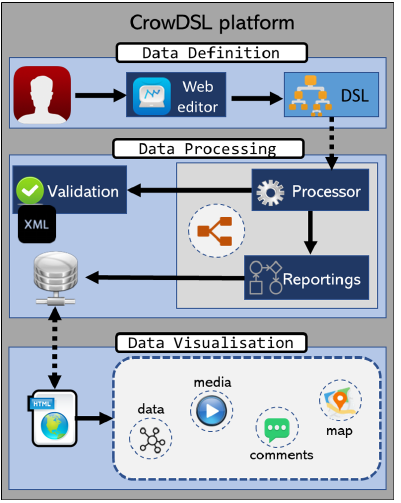
Figure 1. CrowDSL architecture.